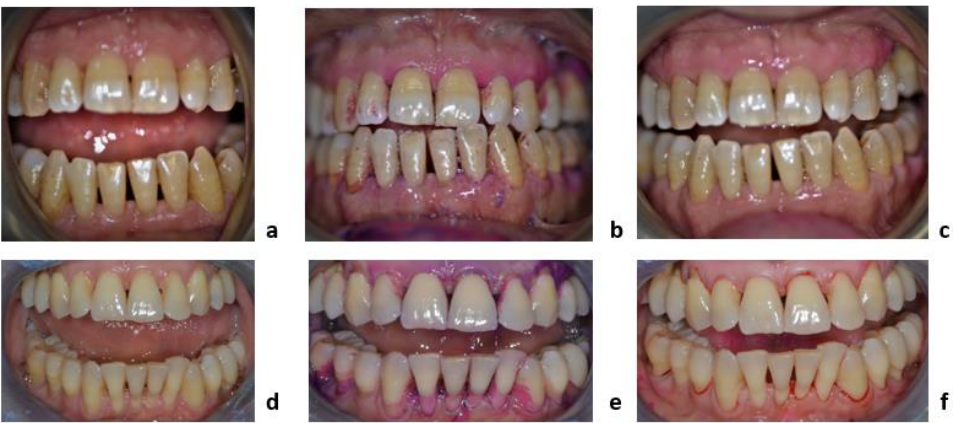
Figure 5. Oral hygiene in two different subjects 48 h after the end of the experimental protocol: we evaluated the overall Gingival Abrasion Assessment. ( a , d ) Patient before oral hygiene; ( b , e ) patient during treatment: the gums are dried with compressed air and a revealing solution applied for a better visualization of the areas in question; ( c , f ) patient after oral hygiene.